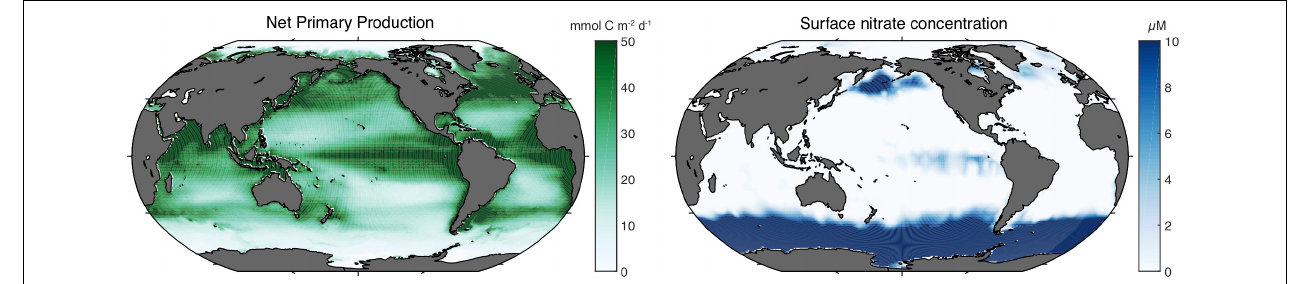
FIGURE 1 | Net primary production and sea surface nitrate concentrations in the global ocean. The left panel shows the annual mean net primary production (in mmol C m – 2 day – 1 ) as estimated from satellite-observed sea surface color and temperature averaged from three algorithms (Dunne et al., 2007). The right panel shows the minimum monthly sea surface nitrate concentration (in µ M) from the World Ocean Atlas (Boyer,